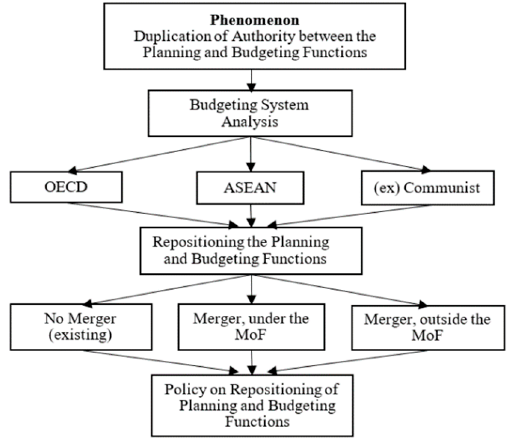
Figure 1. Framework of Thinking.